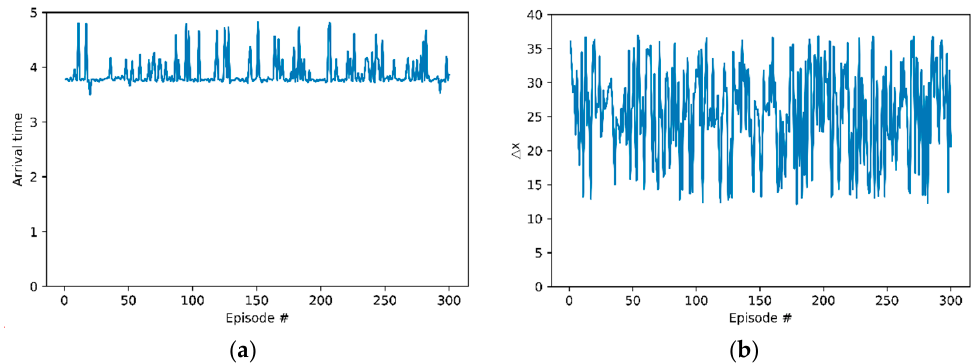
Figure 6. Evaluation results: ( a ) arrival times of the host vehicle in next lane; ( b ) differences between the position x of the host vehicle and the remote vehicle.